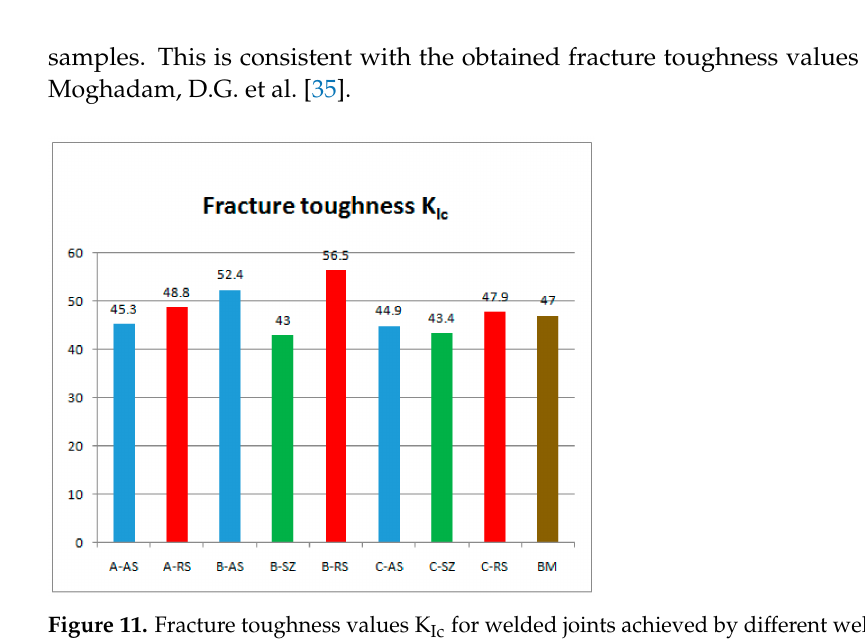
Figure 11. Fracture toughness values K Ic for welded joints achieved by different welding parameters and different notch positions.